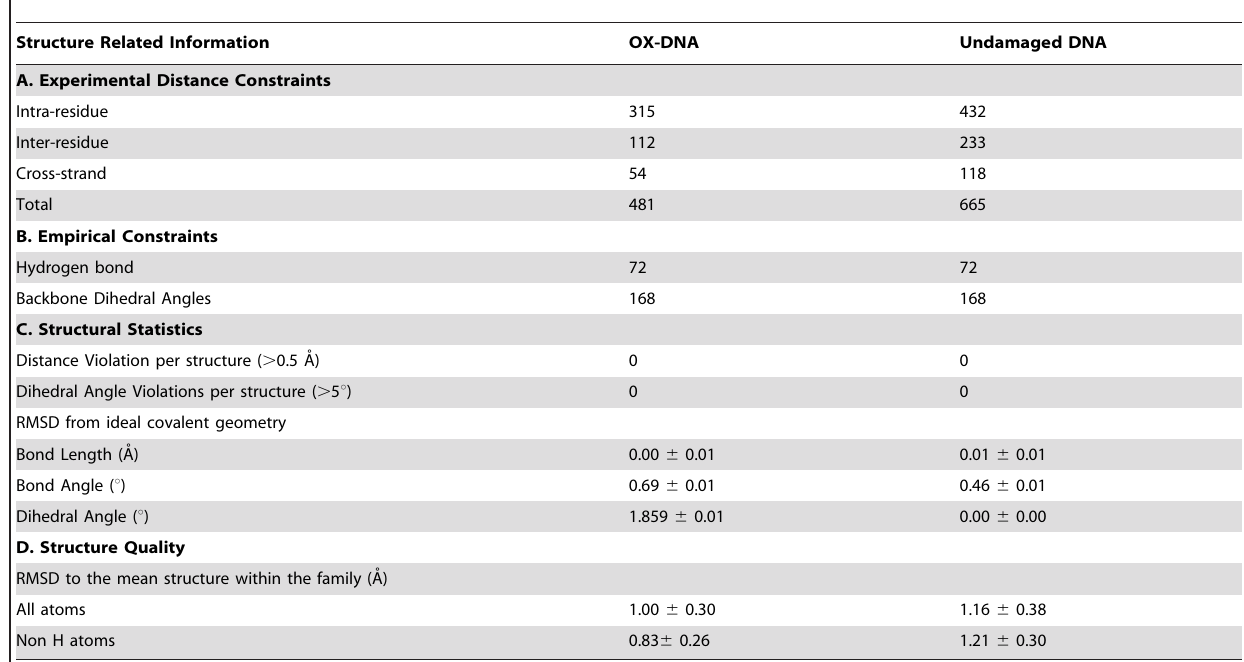
Table 2. Structural statistics for both OX-DNA and undamaged-DNA structures in the TGGT sequence context.